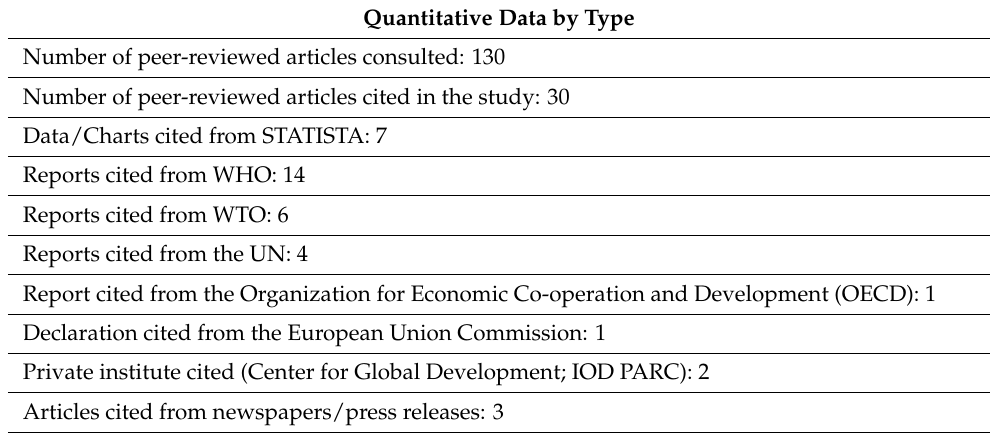
Table 1. Quantitative data used in the study.